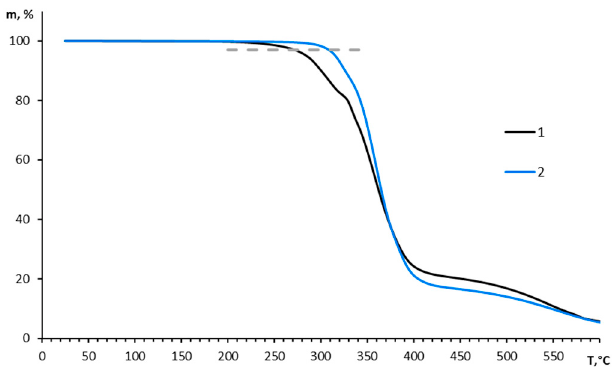
Figure 6. TGA curves for films with pure PTMSP-3 (1) and with Irganox 1010 (2).